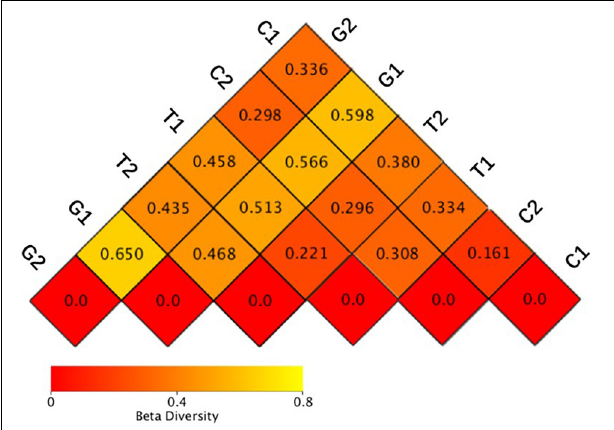
FIGURE 3 | Heatmap of beta diversity index. C1: cultivated land with distance to river from 100 to 200 m; C2: cultivated land with distance to river from 300 to 500 m; G1: grassland with distance to river from 100 to 200 m; G2: grassland with distance to river from 300 to 500 m; T1: forestland with distance to river from 100 to 200 m; T2: forestland with distance to river from 300 to 500 m.